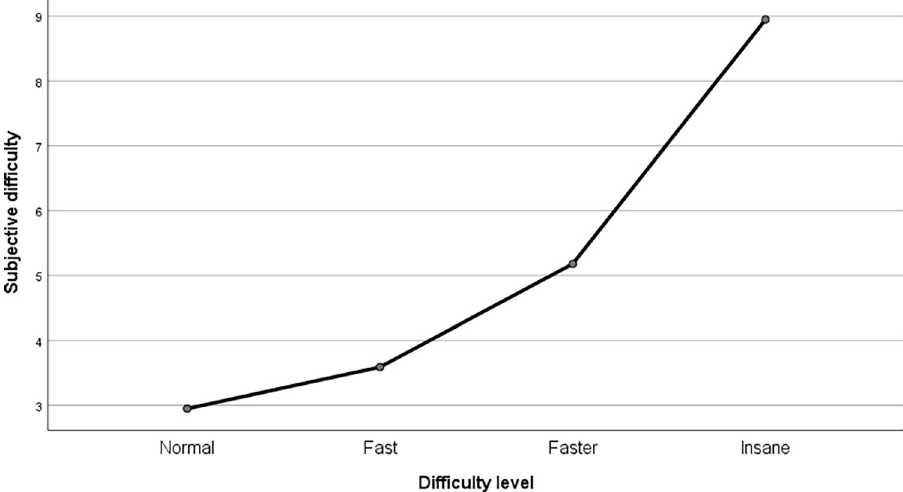
Fig 2. The results of the manipulation check. Subjective difficulty depending on the difficulty